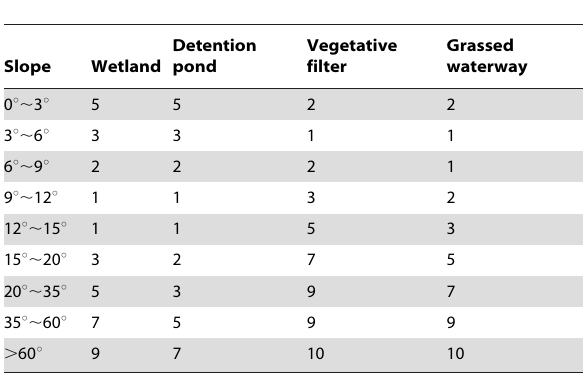
Table 5. The quantified results in accordance with the degree of the